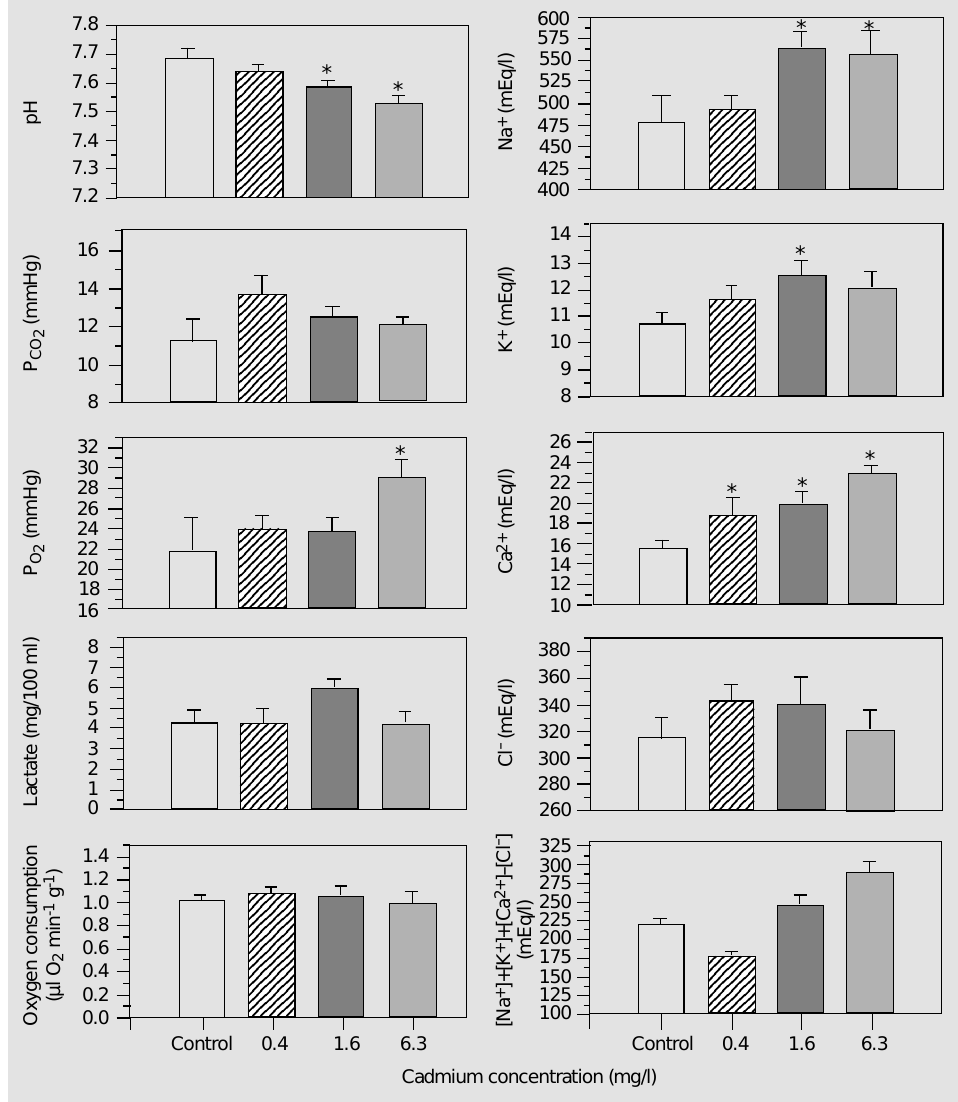
Figure 1 - Mean values (± SEM) of hemolymph parameters and physiological variables for Chas- magnathus granulata exposed to various concentrations of cad- mium (mg/l) for 96 h at 12‰ sa- linity. Control: Water dilution control. N = 10 in all cases. *P<0.05 compared to control (one-way ANOVA followed by planned comparisons